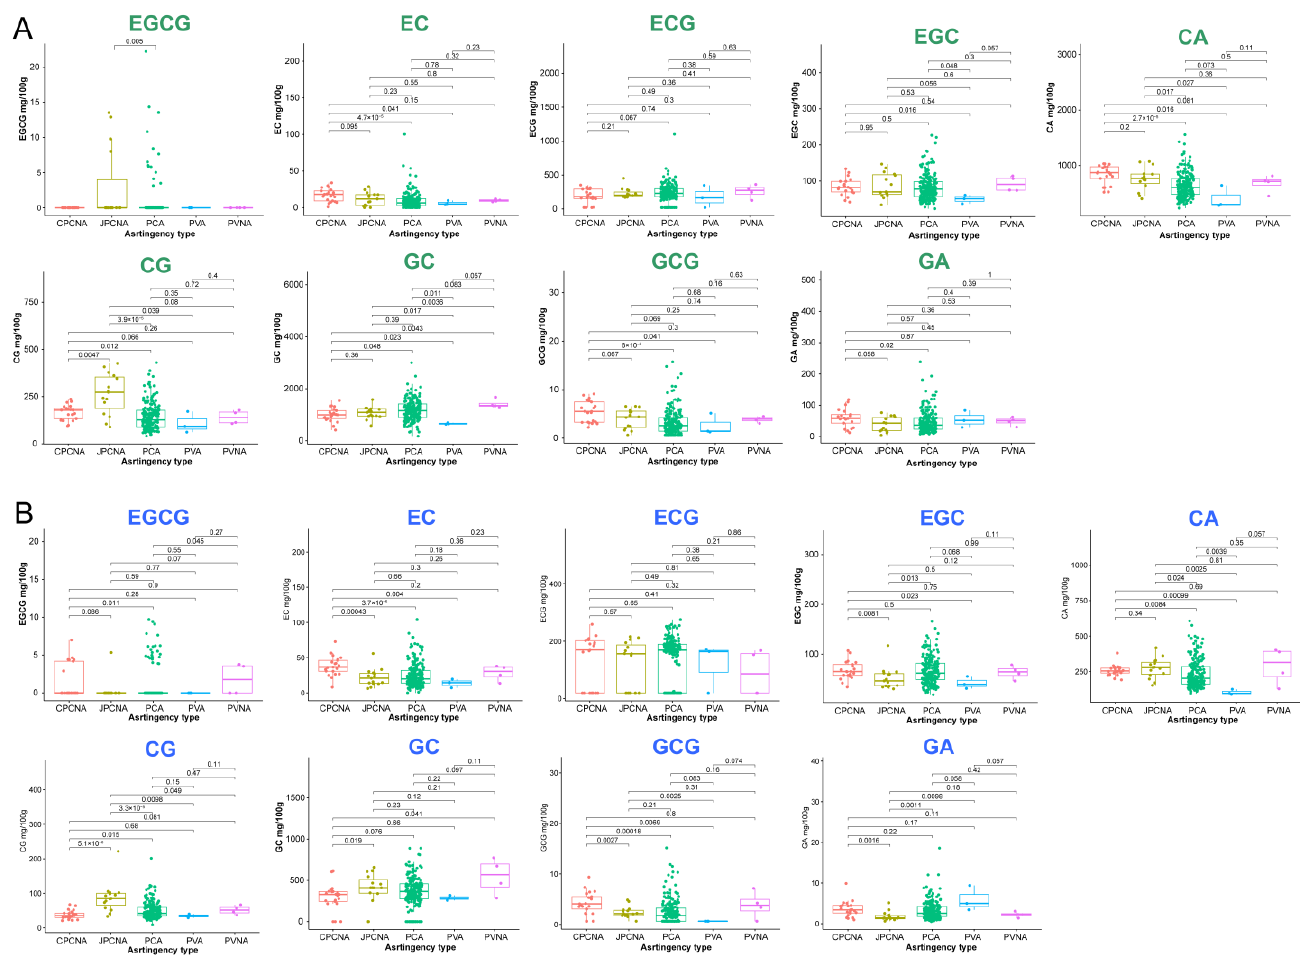
Figure 4. The catechin composition of different astringency types of persimmon leaves (( A ) young leaves; ( B ) adult leaves).